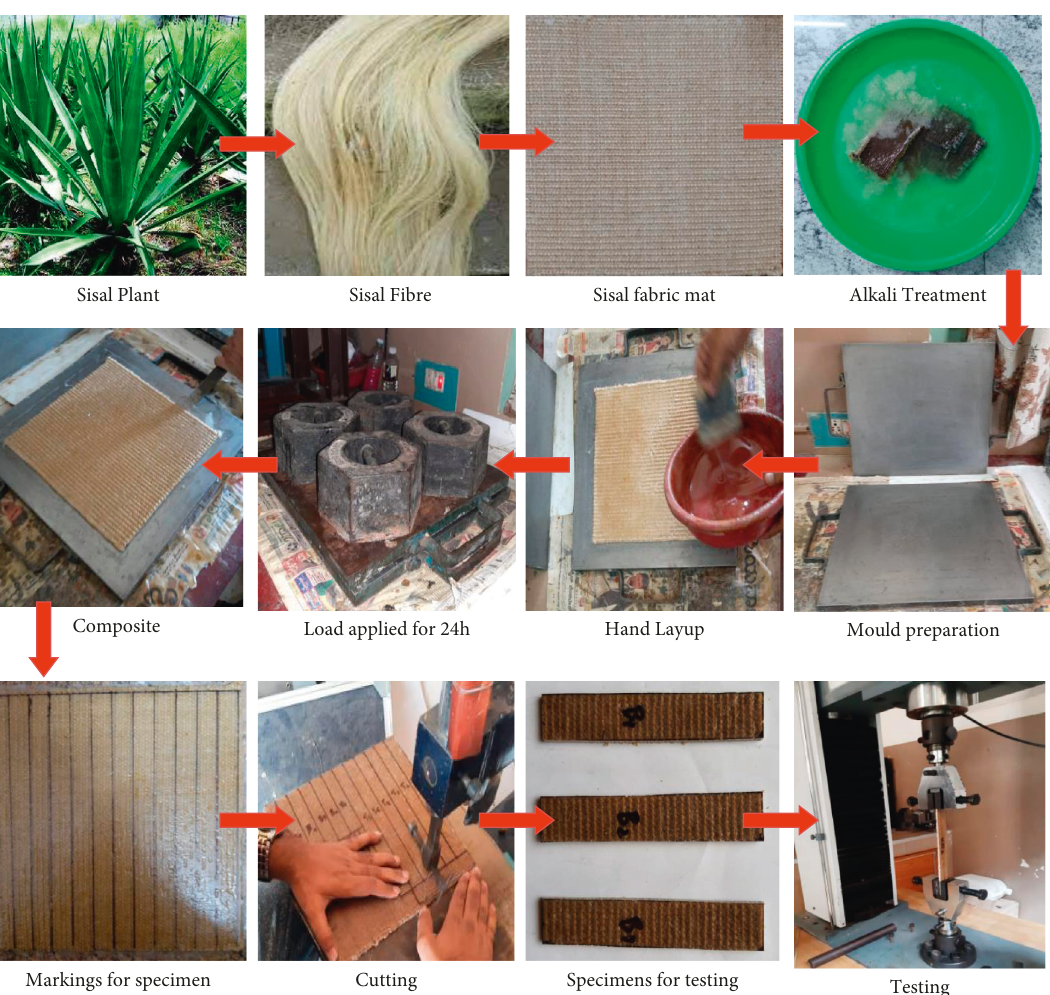
Figure 4: Preparation and testing of sisal fibre-reinforced